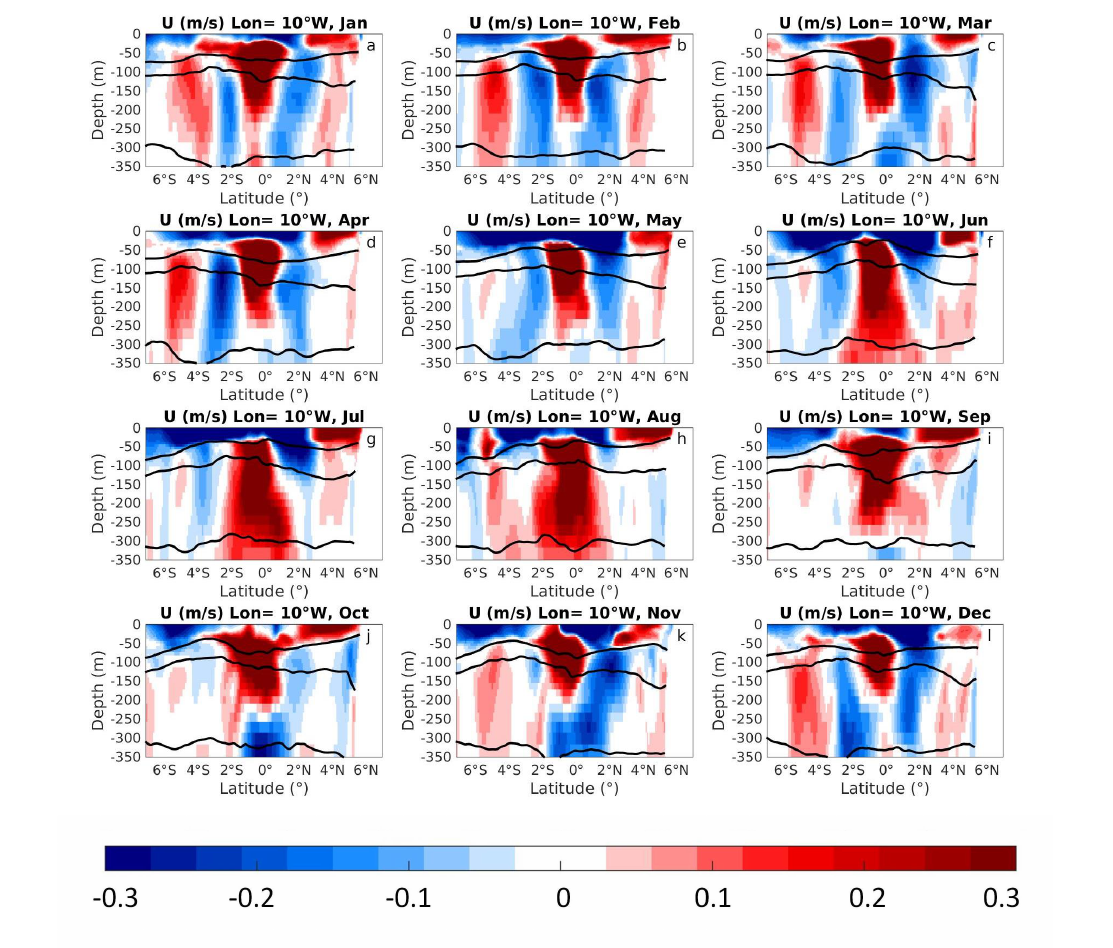
Figure 3. Meridional sections of zonal velocity U at 10 ◦ W on the 15th of each month (instantaneous fields) for 2015. The colorbar ranges from − 0.3 to 0.3 m/s. Thick black lines are associated with the position of isopycnic surfaces with potential density ρ = 1025.5, 1026.2 and 1026.75 kg · m − 3 . Strong variability of instantaneous currents (strength, meridional and vertical positions)